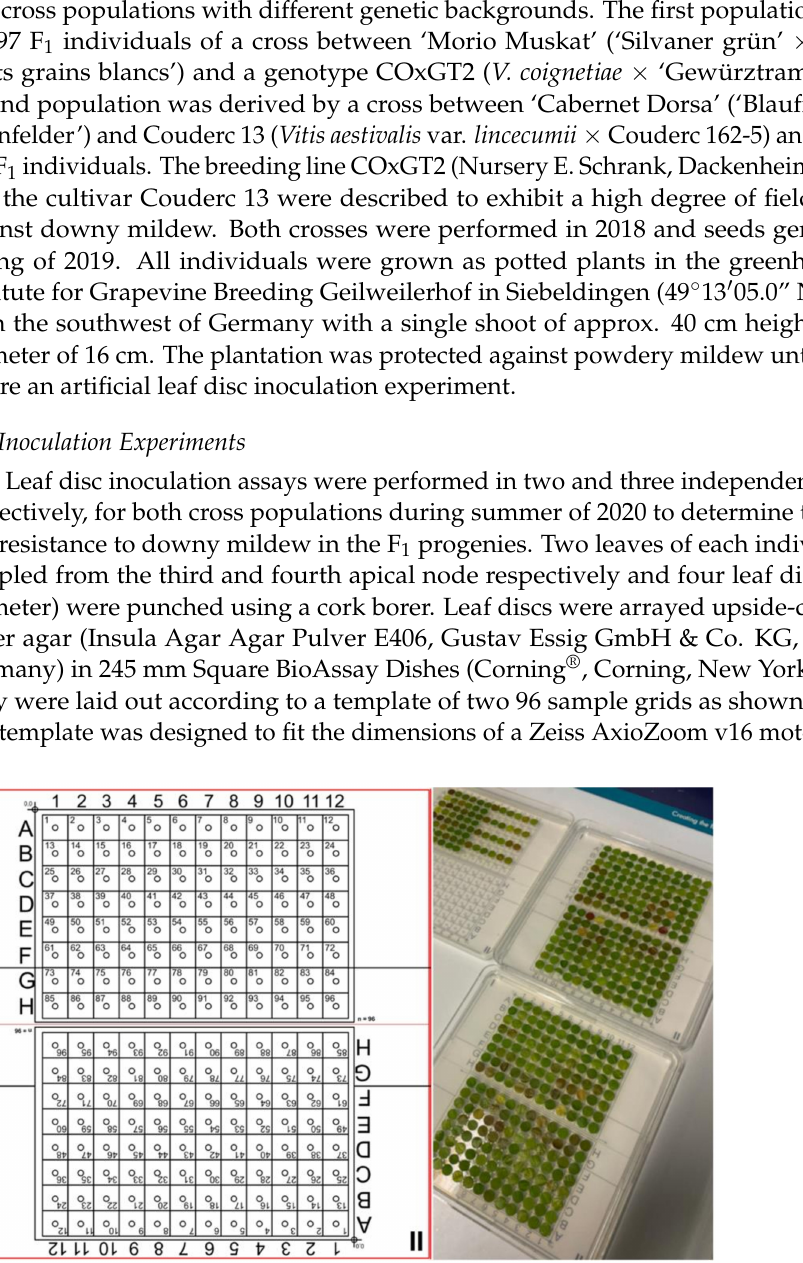
Figure 1. Template used for laying out leaf discs on a square 24.5 cm × 24.5 cm Petri dish filled with water agar and a picture of square dishes with leaf discs on